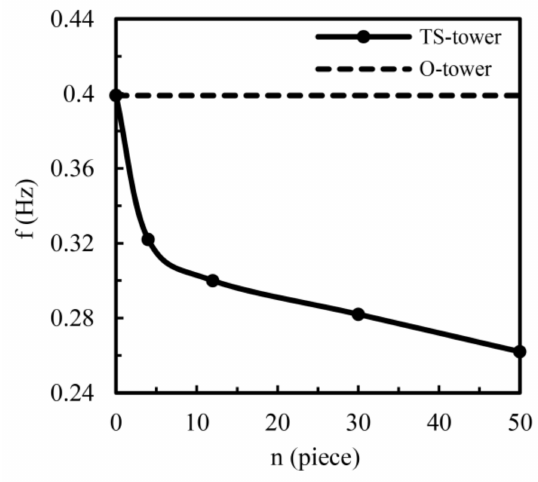
Figure 10. Influence of the n parameter on the VIV frequency.